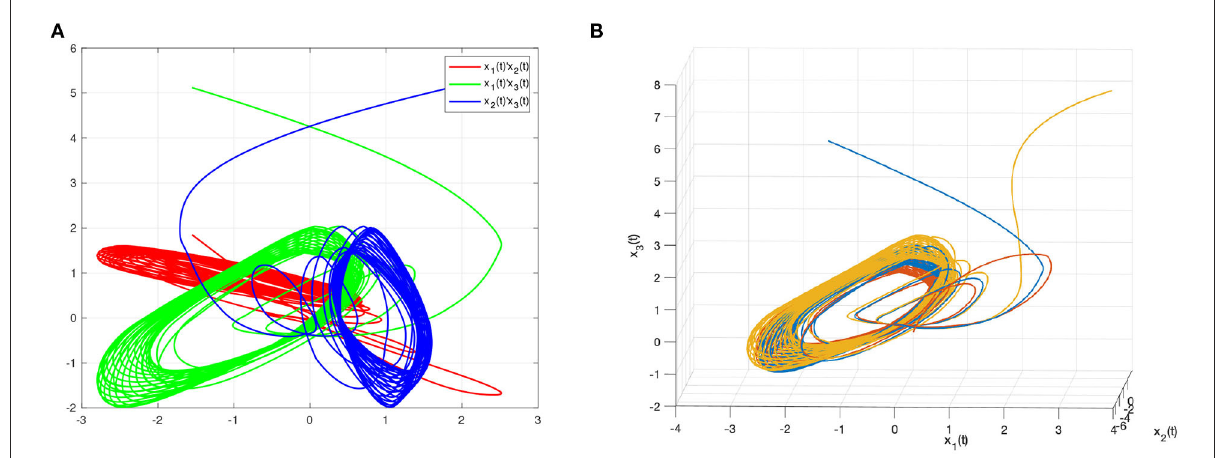
FIGURE3 The chaotic dynamic behavior of systems (8) and (9). (A) Time evolutions of systems in a complex space. (B) State curves of systems in a complex plane.